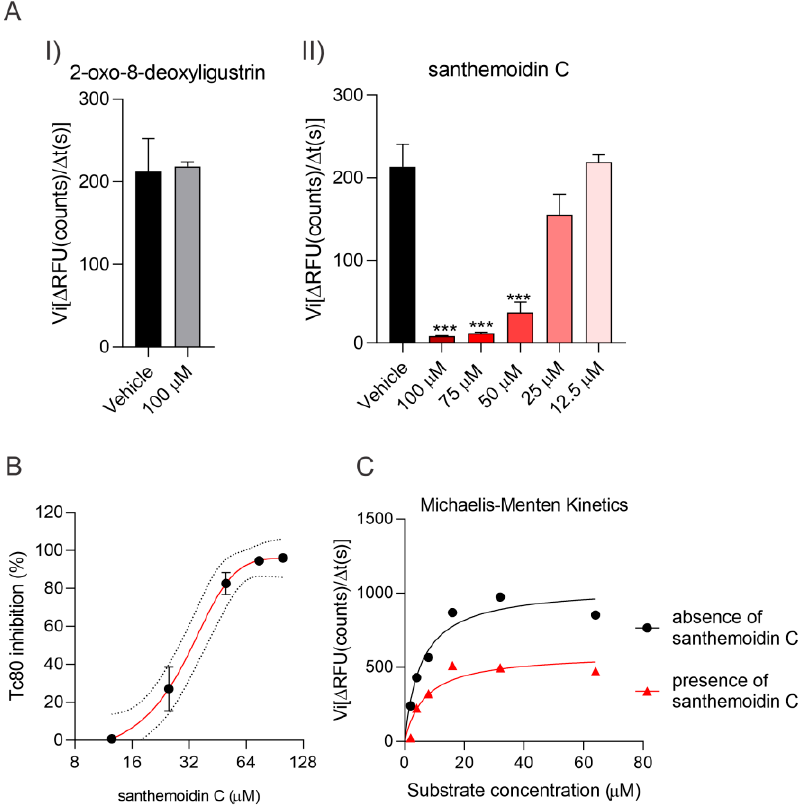
Figure 4. Enzymatic activity of Tc80 was measured by the conversion of the fluorogenic substrate Z-Gly-Pro-7-AMC to AMC in the presence of santhemoidin C or 2-oxo-8-deoxyligustrin. ( A ) Initial reaction velocity (Vi) was determined as the slope ( ∆ RFU/ ∆ time) from the linear region in the RFU vs. time curve for tested concentrations of santhemoidin C ( I ) or 2-oxo-8-deoxyligustrin ( II ). ( B ) Dose-dependent inhibition of Tc80 (0.02 µ g) by santhemoidin C. ( C ) Michaelis-Menten Plot was constructed by non-linear regression to estimate kinetic parameters (Km and V max ) in the presence or absence of 50 µ M santhemoidin C. Results are expressed as the mean ± SEM. Asterisk indicates significant differences compared to vehicle (*** p < 0.001).